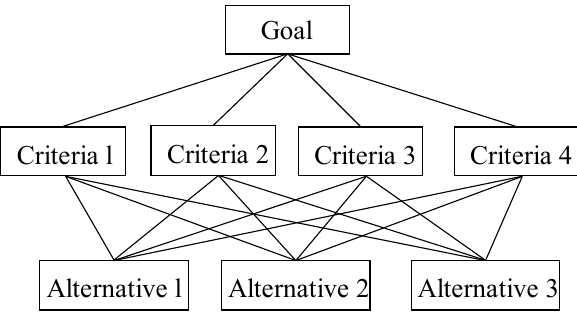
Figure 7. Diagram of AHP method.